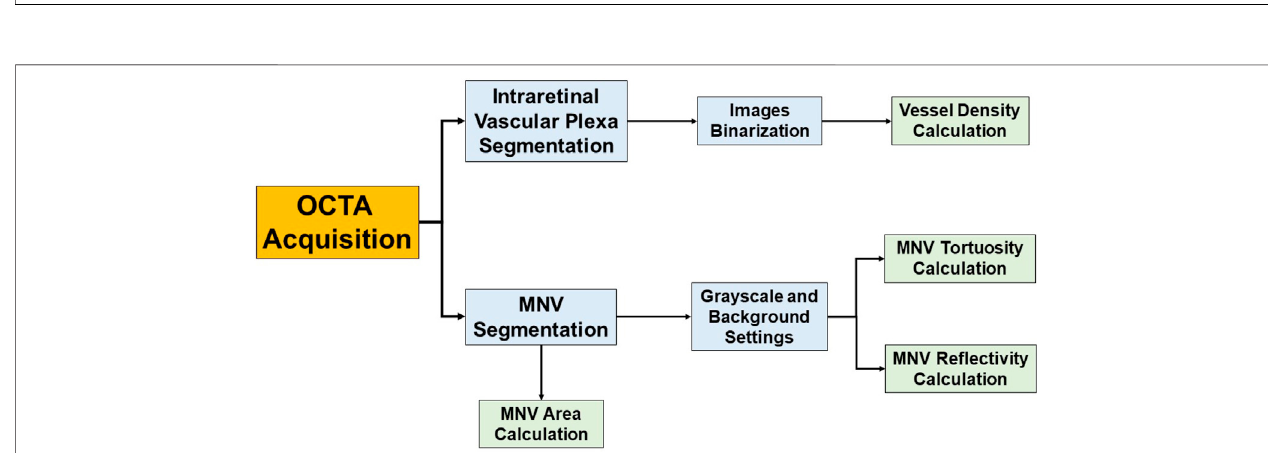
FIGURE 3 | Flowchart showing all the quantitative steps adopted in the present study.